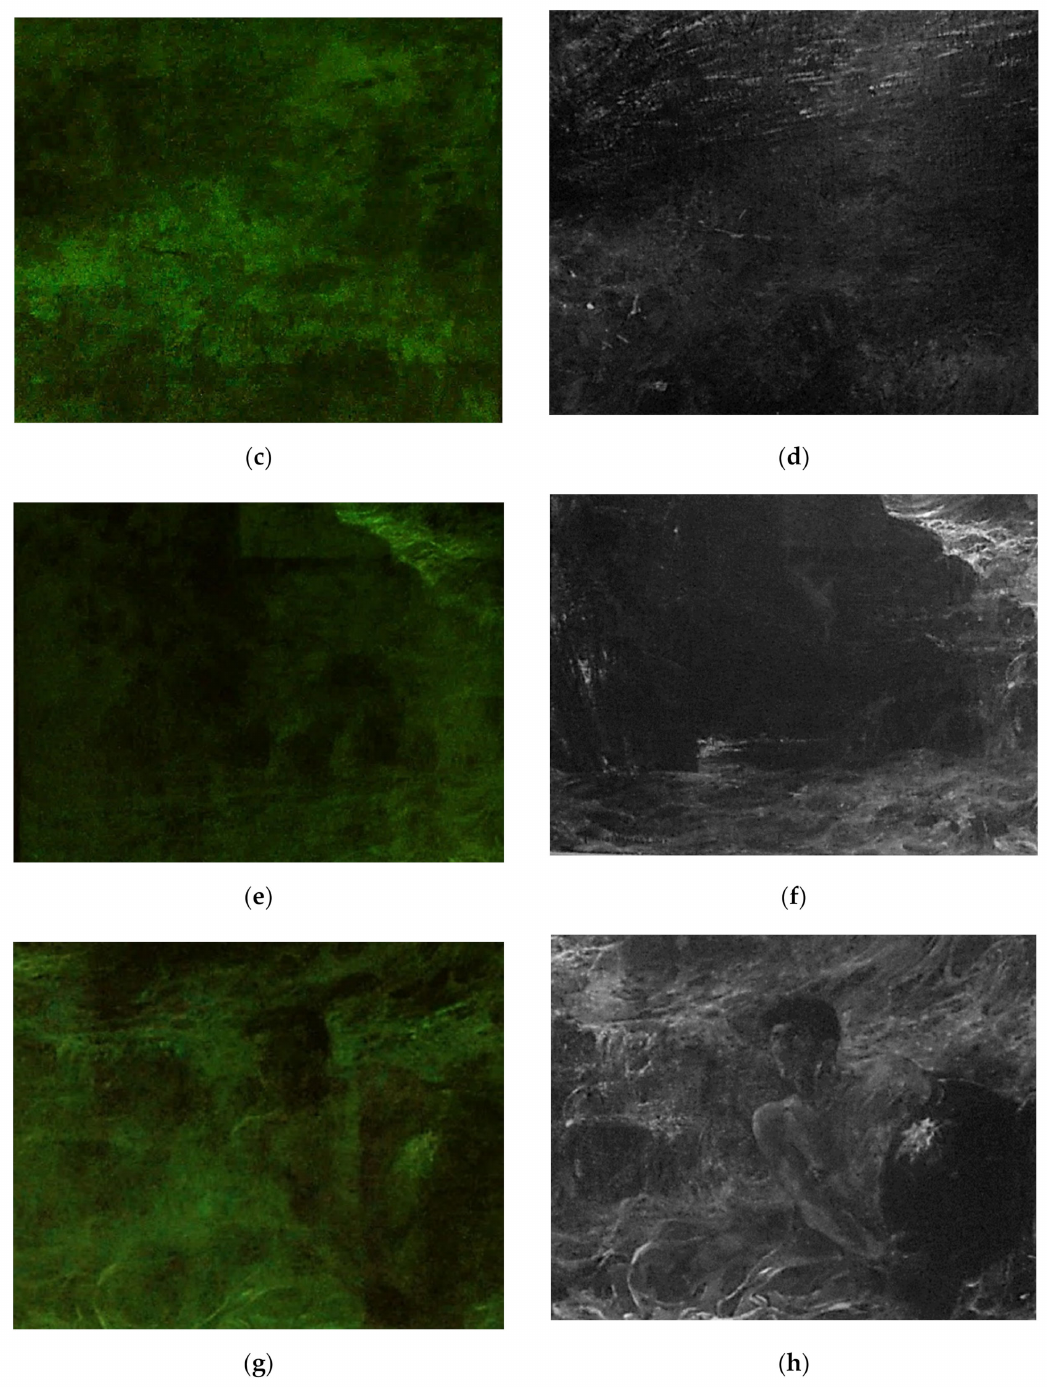
Figure 2. Multispectral imaging: UV light, using the Yellow 495 52 mm F-PRO MRC 022 filter (examples of the restored areas are highlighted in yellow, color gaps in red); IR images using the IR filter at 750 nm. Area n ◦ 1: UV ( a ) and IR ( b ). Area n ◦ 2: UV ( c ) and IR ( d ). Area n ◦ 3: UV ( e ) and IR ( f ). Area n ◦ 4: UV ( g ) and IR ( h